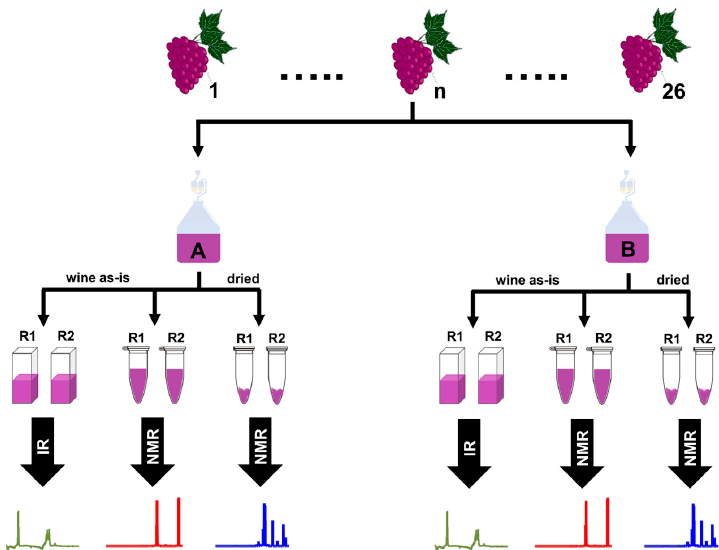
Figure 6. Experimental design for wine analysis. A total of 26 experimental wines were made by using 22 grape varieties. For each experimental wine, two fermentation replicates were prepared (A and B), giving a total of 52 experimental wines. Wine samples were analyzed by FT-IR (wine as-is) and 1 H-NMR spectroscopy (wine as-is and dried wines). Samples for NMR and IR analysis were prepared in duplicates (R1 and R2).